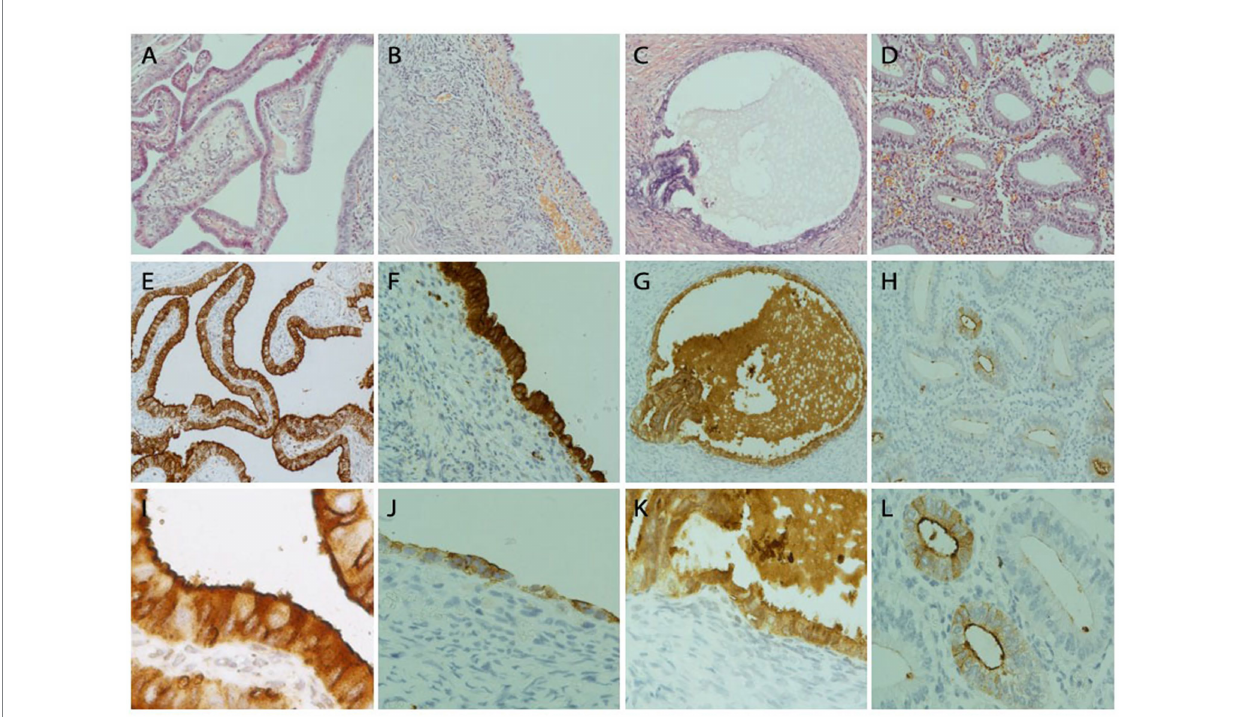
FIGURE 4 FRA protein detection by immunohistochemistry in fallopian tubal, ovarian endometriosis, endosalpingiosis, and endometrial tissue sections. Representative IHC stains of FRA showed strong diffuse FRA expression in the fallopian tube (left column, A,E,I ), ovarian endometriosis (left mid, B,F,J ), and ovarian endosalpingiosis (right mid, C,G,K ), but only focal and weak staining was observed in a case of proliferative endometrium (right column, D,H,L ). FRA staining was mainly cytoplasmic. Membranous stains can be seen when the staining intensity is moderate (E) and luminal stains are more prominent when stains become weak or moderate and magnified (I,L) . Histologic H&E sections are arranged on the top panel. FRA expression in the fallopian tube is illustrated in panels (E,I) , where I (200x) represents the magnification of part of E (100x). FRA expression in 2 ovarian endometriosis cases, with one showing high ( F , 100x) and one showing intermediate ( J , 100x) FRA expression levels. FRA expression in endosalpingiosis is shown in panels G (100x) and K (200x). Focal glandular with a mainly luminal pattern is seen in an endometrial sample ( H , 100x; L ,